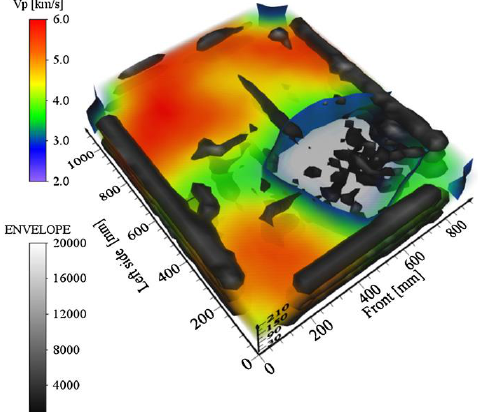
Figure 1: Combined 3D rendering of UT and GPR